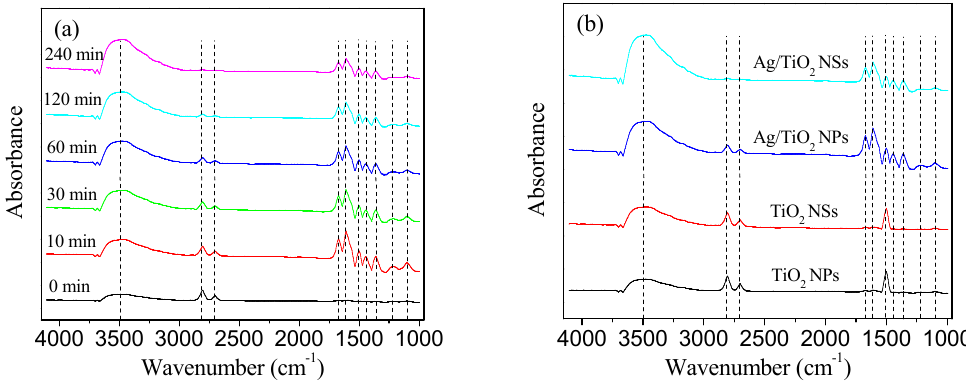
Figure 13. ( a ) Dynamic changes in the in situ DRIFT spectra of HCHO photocatalytic oxidation under visible light; ( b ) the in situ DRIFT spectra of different catalysts for photocatalytic oxidation of HCHO at 120 min.